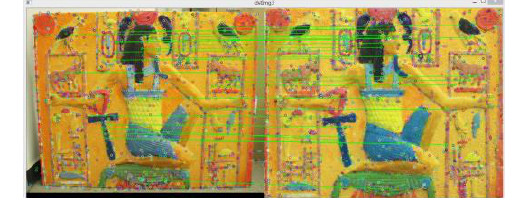
Figure 5. Matching results of optical images with point cloud RGB